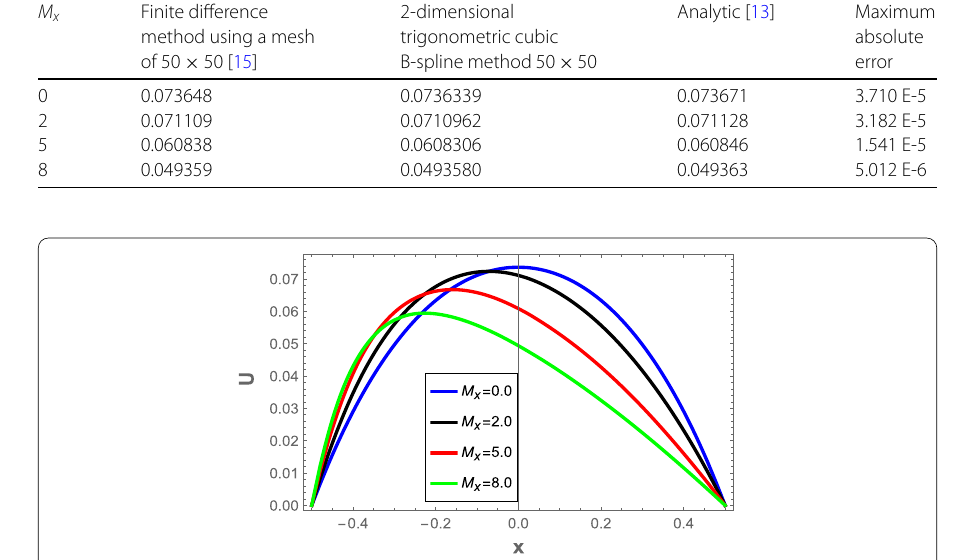
Table 3 The duct’s U is in the middle. Simulations using finite difference and analytic methods were contrasted M x Finite difference method using a mesh